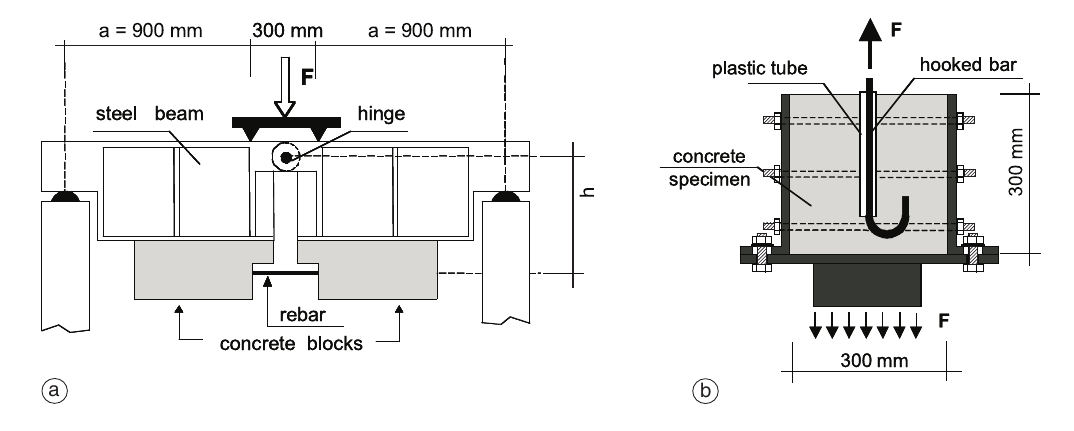
Fig. 7a,b. Test setup: a) beam-test and b)